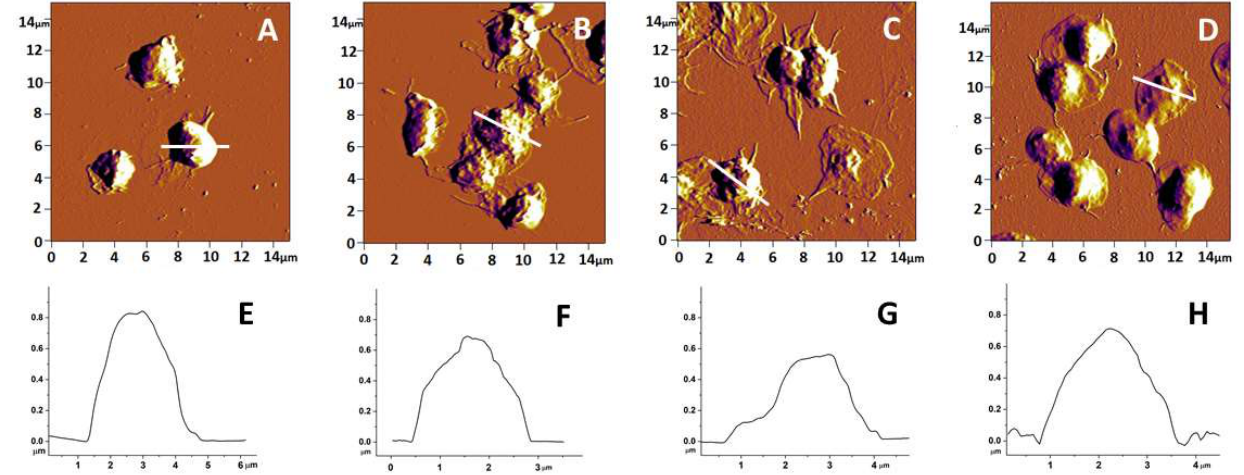
Figure 1. AFM images of platelets from healthy individuals ( A ) and patients with PD ( B ), ALS ( C ) and AD ( D ), and cross-sectional profiles ( E – H ) corresponding to the transversal white lines in panels ( A – D ).